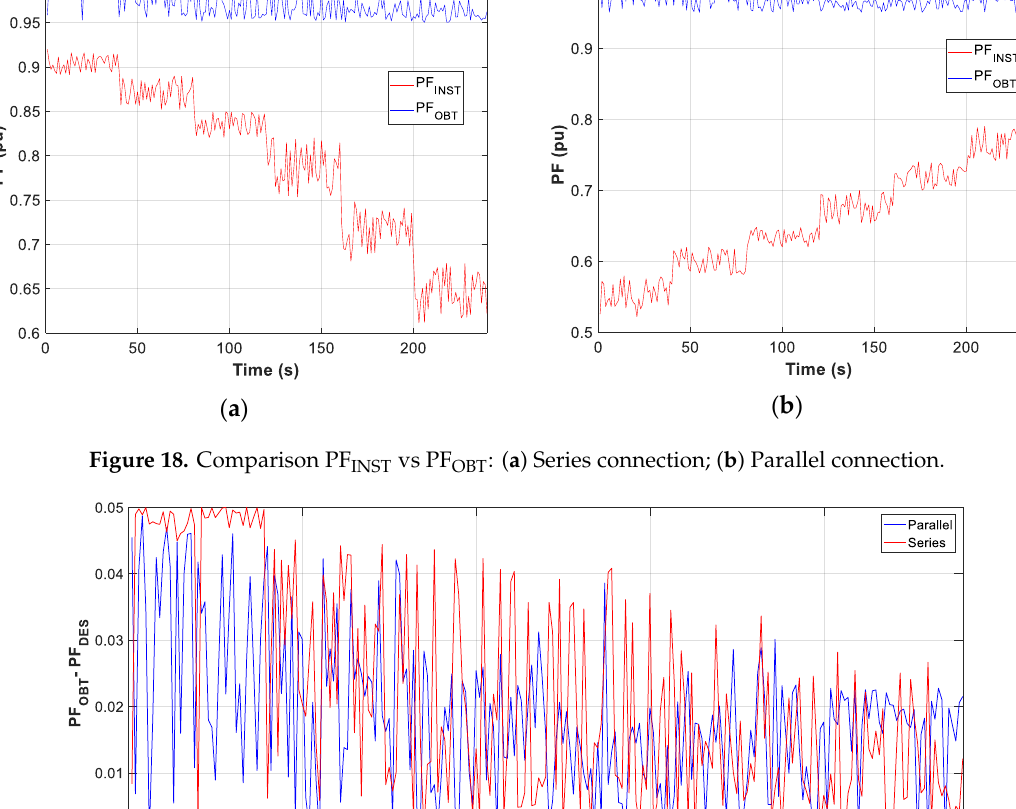
Figure 17. Comparison obtained vs optimal capacity: ( a ) Series connection; ( b ) Parallel connection.